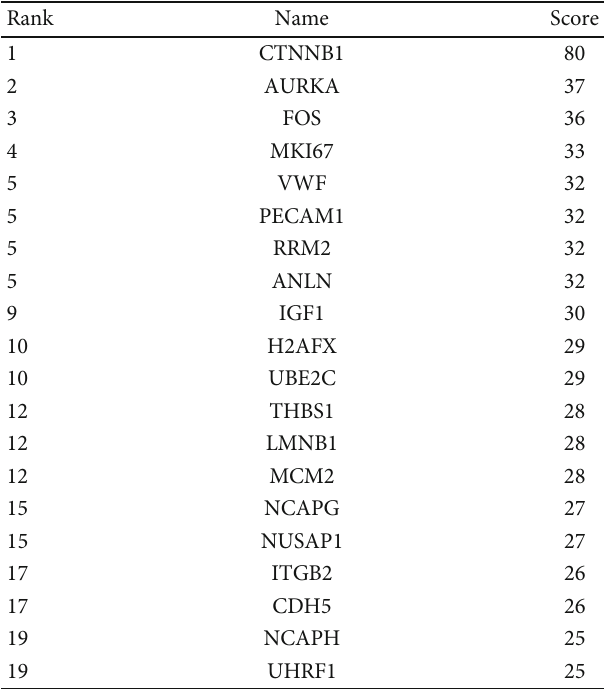
Table 3: Top 20 hub genes in the PPI